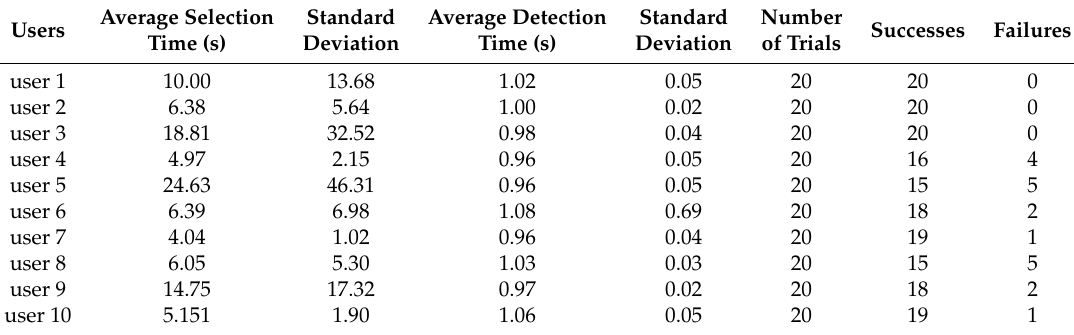
Table 5. Object selection using the estimation of gaze point and detection of the type of